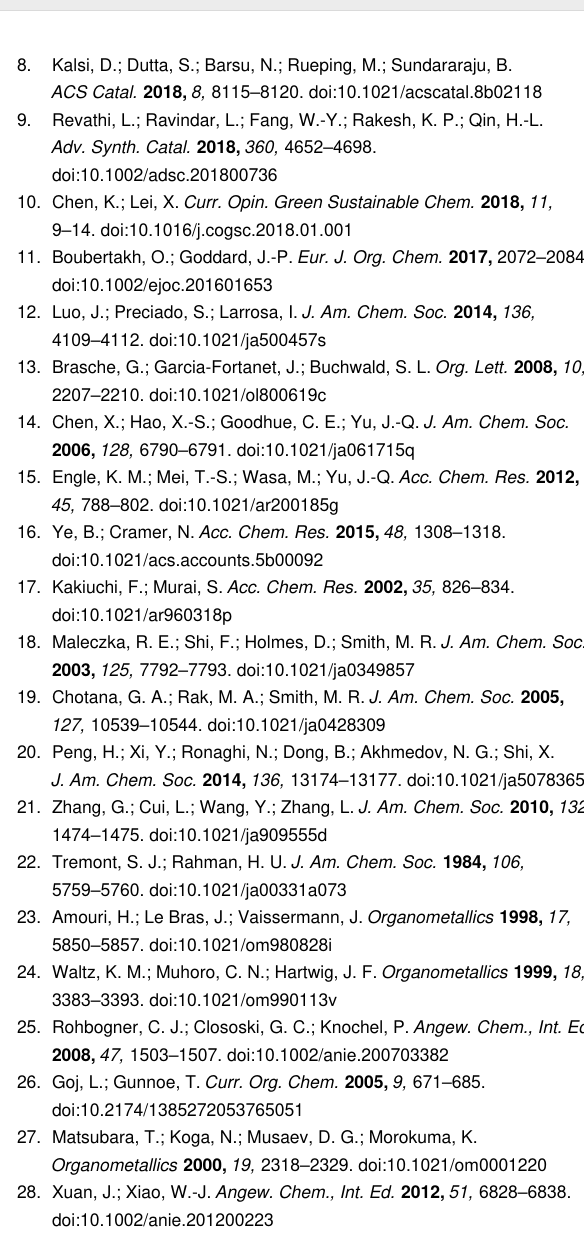
Figure 25: Plausible mechanism for the synthesis of substituted benzonitrile derivatives in the presence of 3a